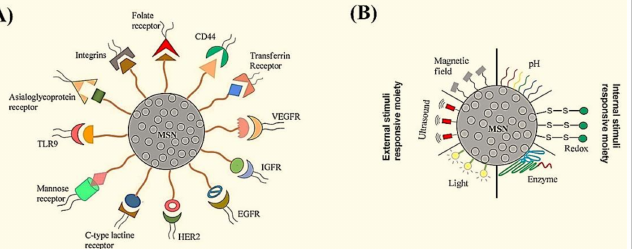
Figure 4. Schematic representation of ( A ) possible surface modifications of MSNs for active targeting to the receptors over-expressed in cancer microenvironment and ( B ) the main stimuli-responsive gatekeepers in decorated MSNs for controlled release of therapeutics in the tumor site. Reproduced from ref [130]. Copyright 2020 MDPI